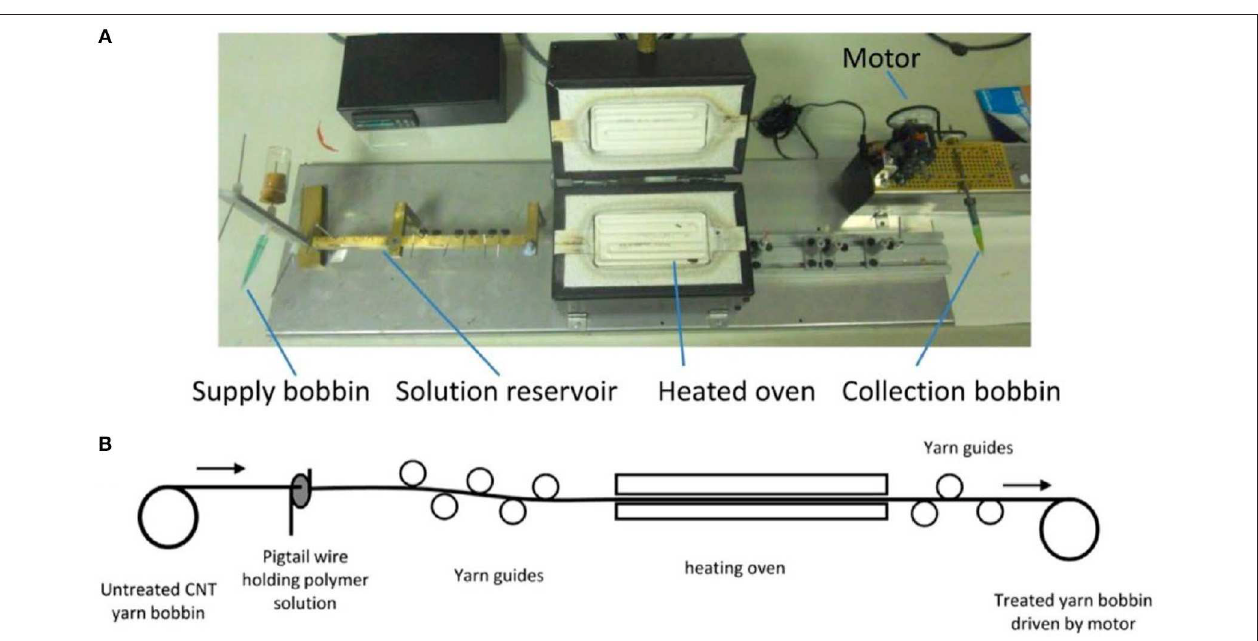
FIGURE 6 | (A) Photograph and (B) schematic diagram of the continuous dip-coating process apparatus for hybrid fiber fabrication (Su et al., 2014).